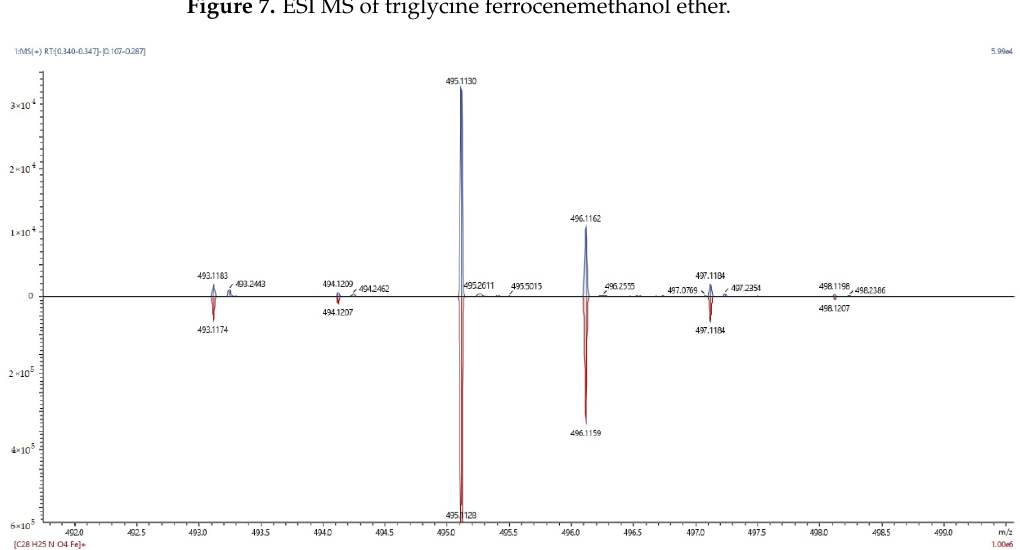
Figure 8. ESI MS glycyl ferrocenemethanol.